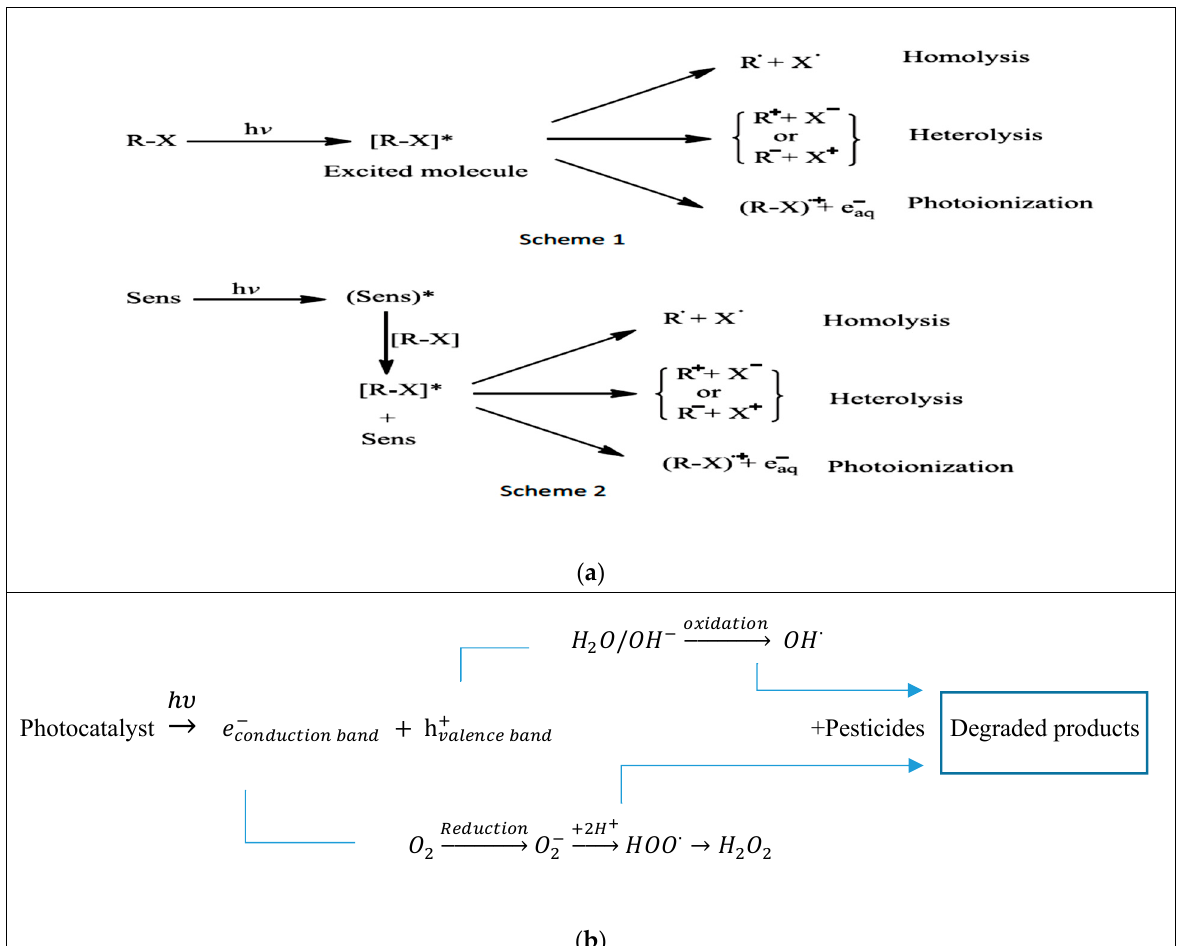
Figure 3. Scheme of photoremediation process; ( a ) direct photolysis process (the scheme is quoted from [27]) and ( b ) photocatalysis process (the scheme is quoted from [31] ).